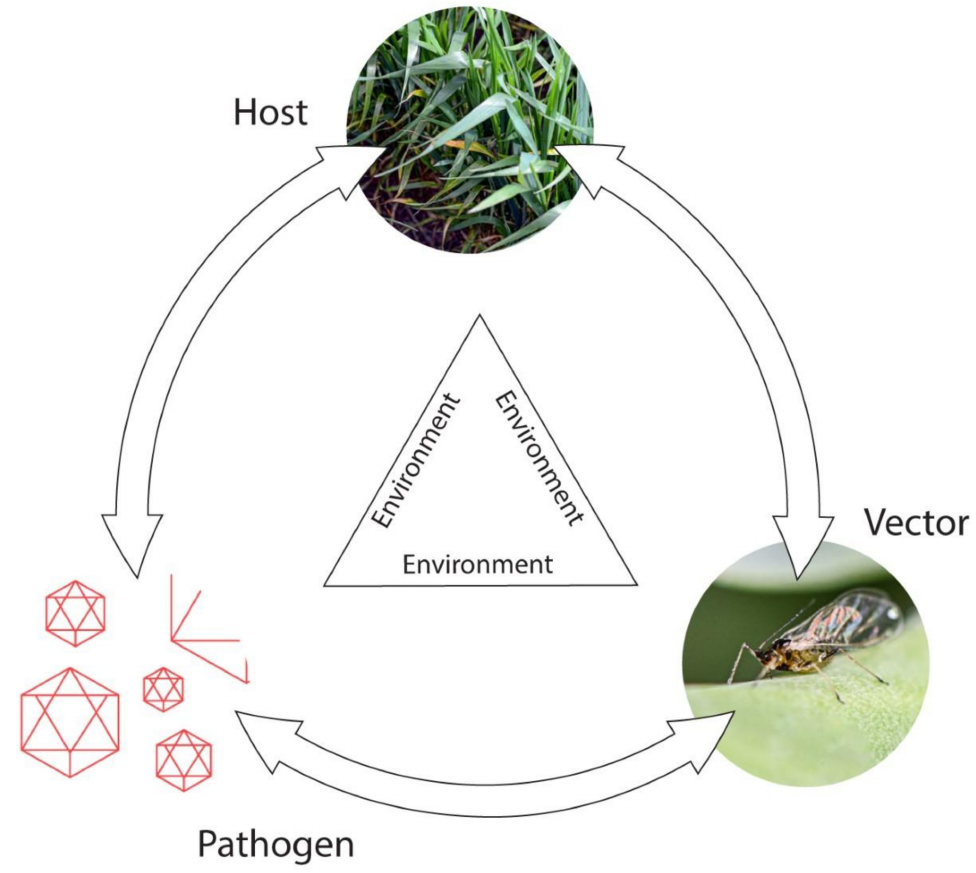
Figure 2. Disease triangle for vector-borne virus pathosystem scenarios. Arrows represent interac- tions between the different triangle